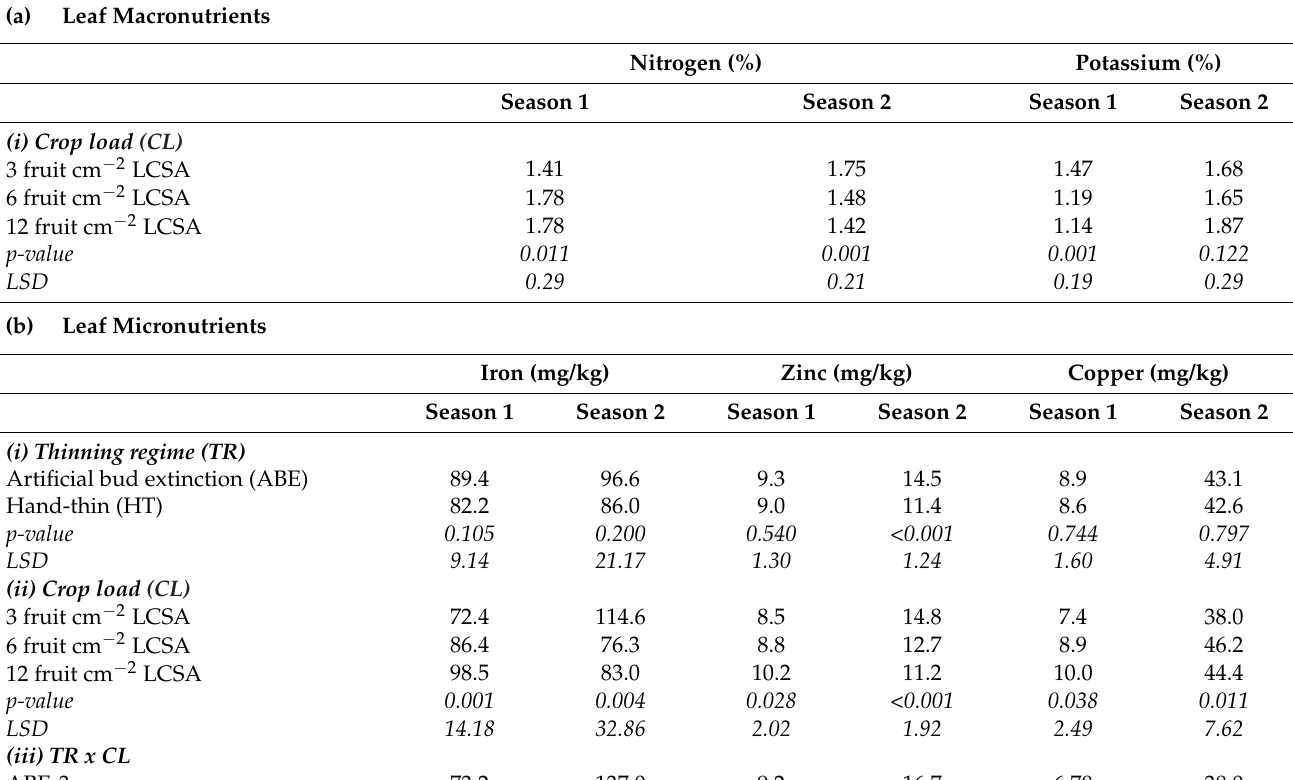
Table 4. Effect of thinning regime (artificial bud extinction (ABE) or hand thinned (HT)) and crop load (3, 6, or 12 fruit cm − 2 limb cross-sectional area (LCSA)) on leaf macronutrient and micronutrient concentrations in season 1 and